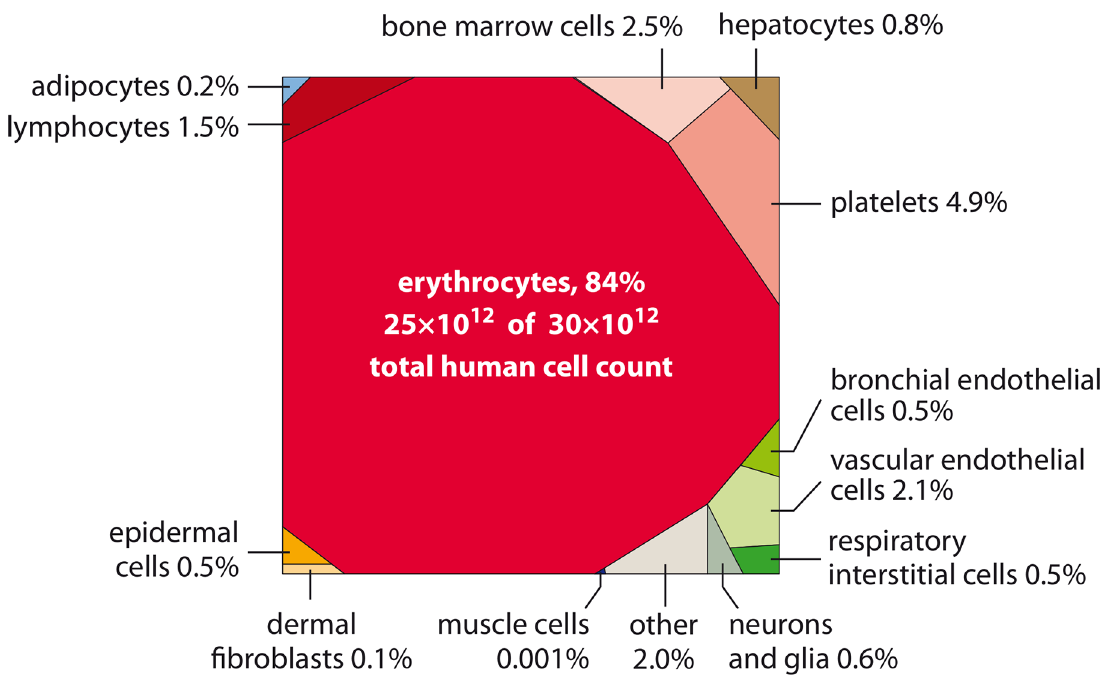
Fig 2. The distribution of the number of human cells by cell type. Representation as a Voronoi tree map where polygon area is proportional to the number of cells. Visualization performed using the online tool at http://bionic-vis.biologie.uni-